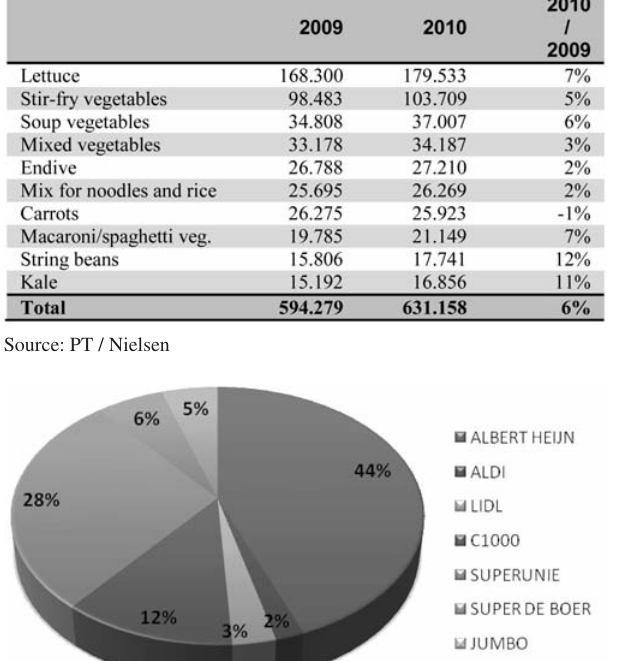
Figuur 4. Supermarket sales of canned vegetables (value) Source: PT / Nielsen